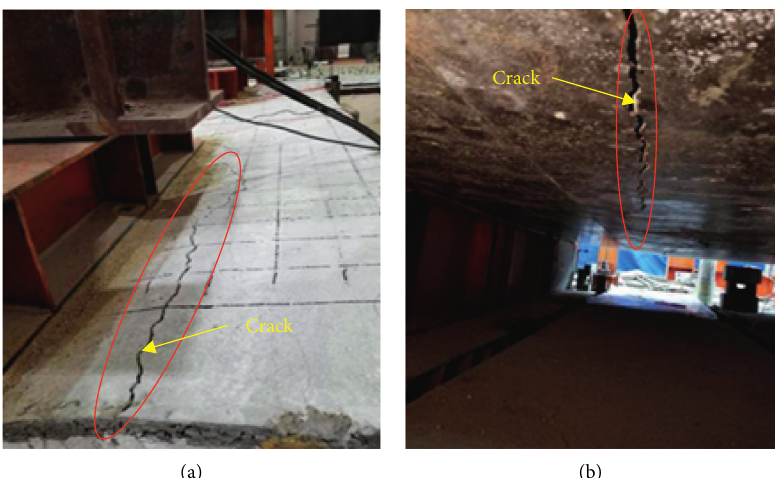
Figure 8: The cracks in the wall during the experiment: (a) the crack in the position of the loading beam; (b) the penetrating crack in the experimental wall.